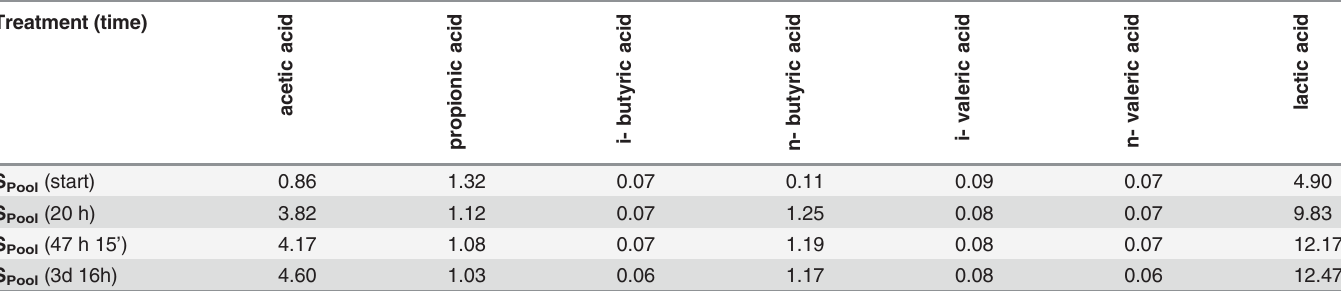
Table 2. Concentration (g/kg fresh weight) of VFA and lactic acid, in treatment S Pool during the fermentation process. Treatment